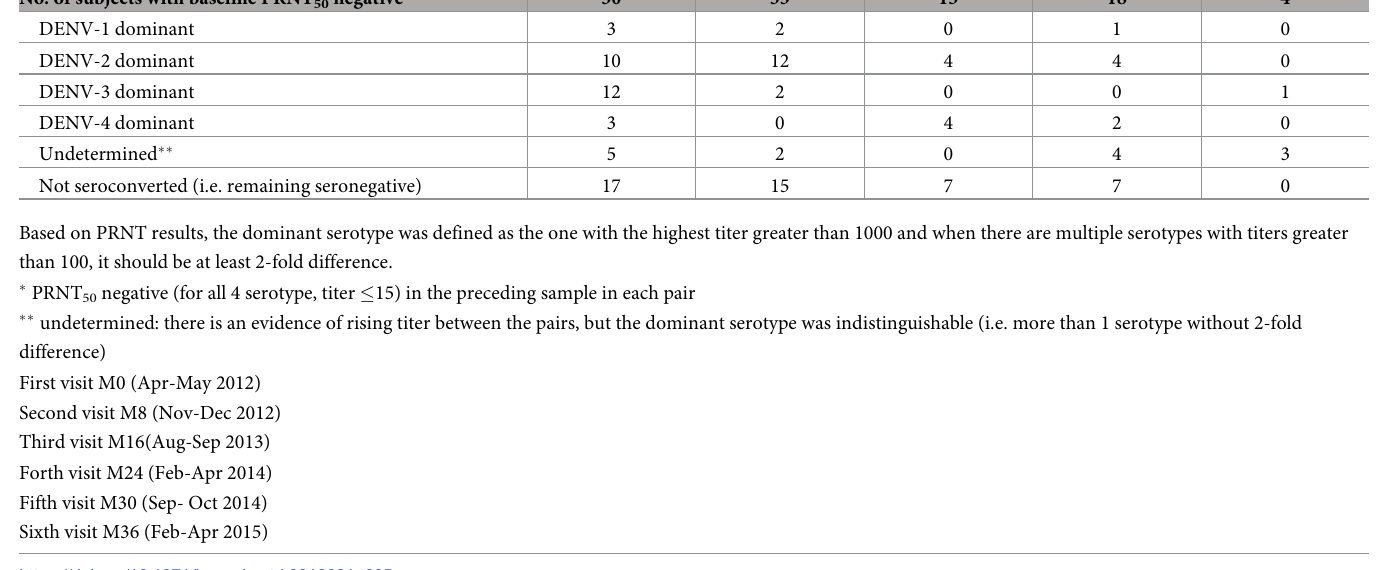
Table 5. DENV serotypes determined by PRNT 50 in subjects with baseline PRNT 50 negative � . PRNT 50